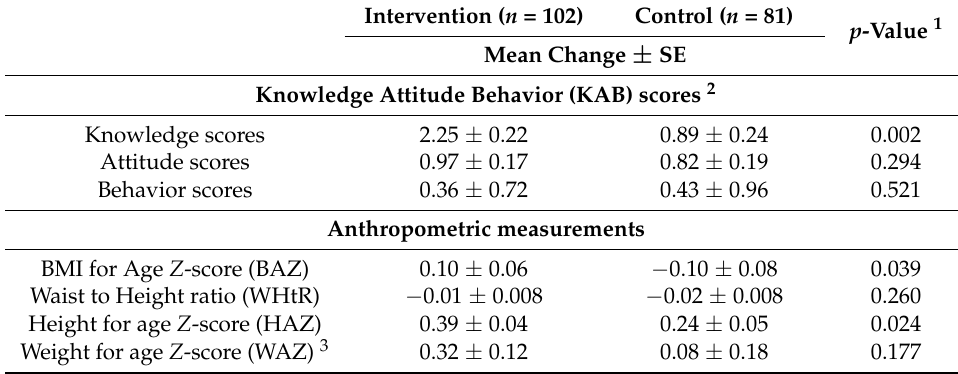
Table 2. Between-group differences (intervention versus control) in mean change of nutrition knowledge, attitude, behavior scores and anthropometric measures of school-aged children ( n = 183).